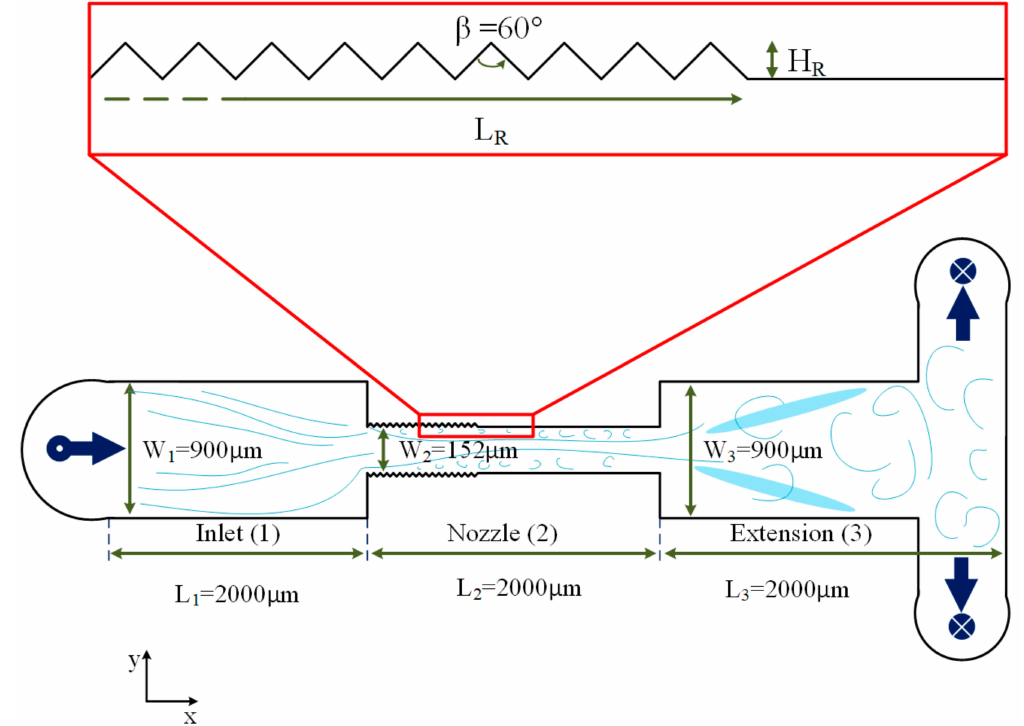
Figure 1. The configuration of the microfluidic device consisting of three main sections—inlet, nozzle, and extension, with wall roughness elements (the total length of roughness elements ( L R ) and height of the roughness elements ( H R